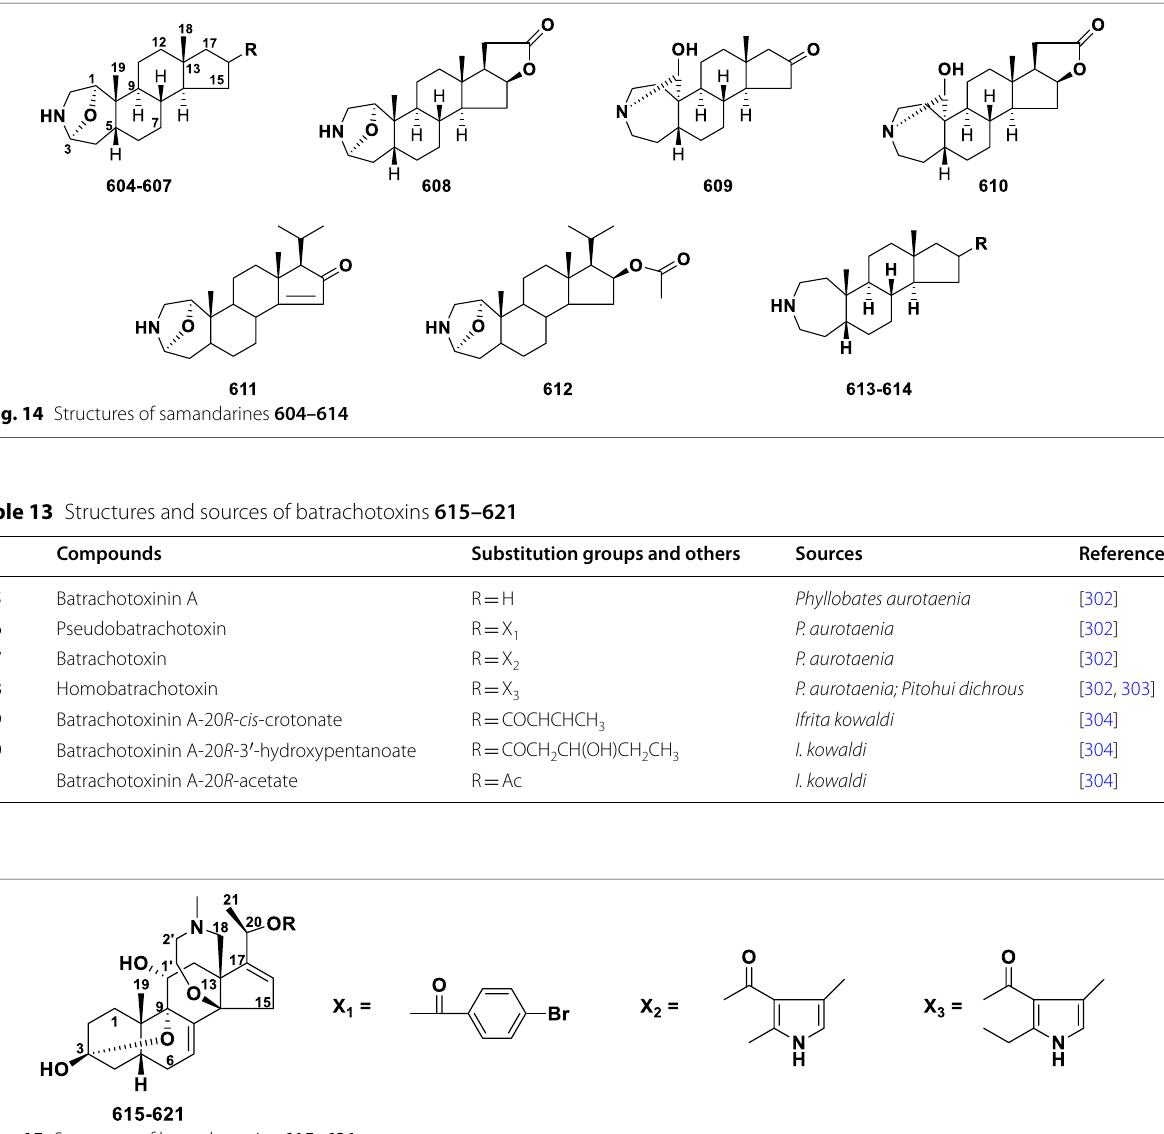
Fig. 15 Structures of batrachotoxins